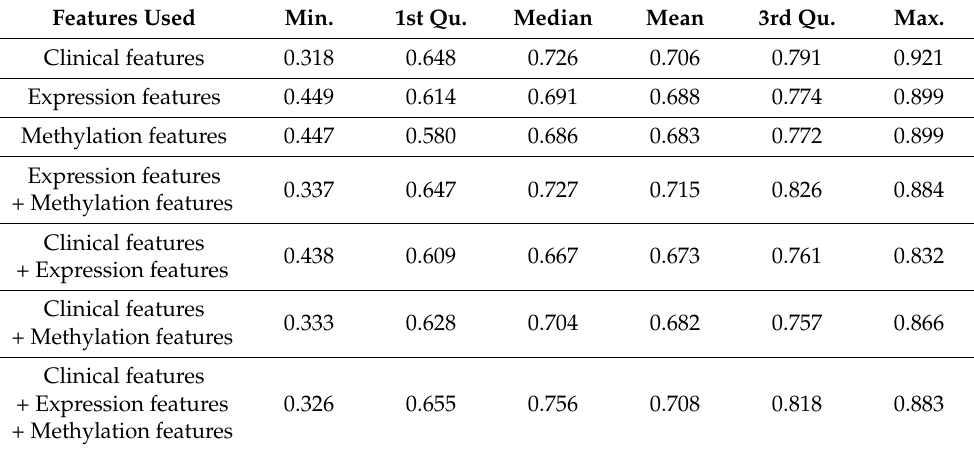
Table 2. The prediction performances of each model were compared by the concordance